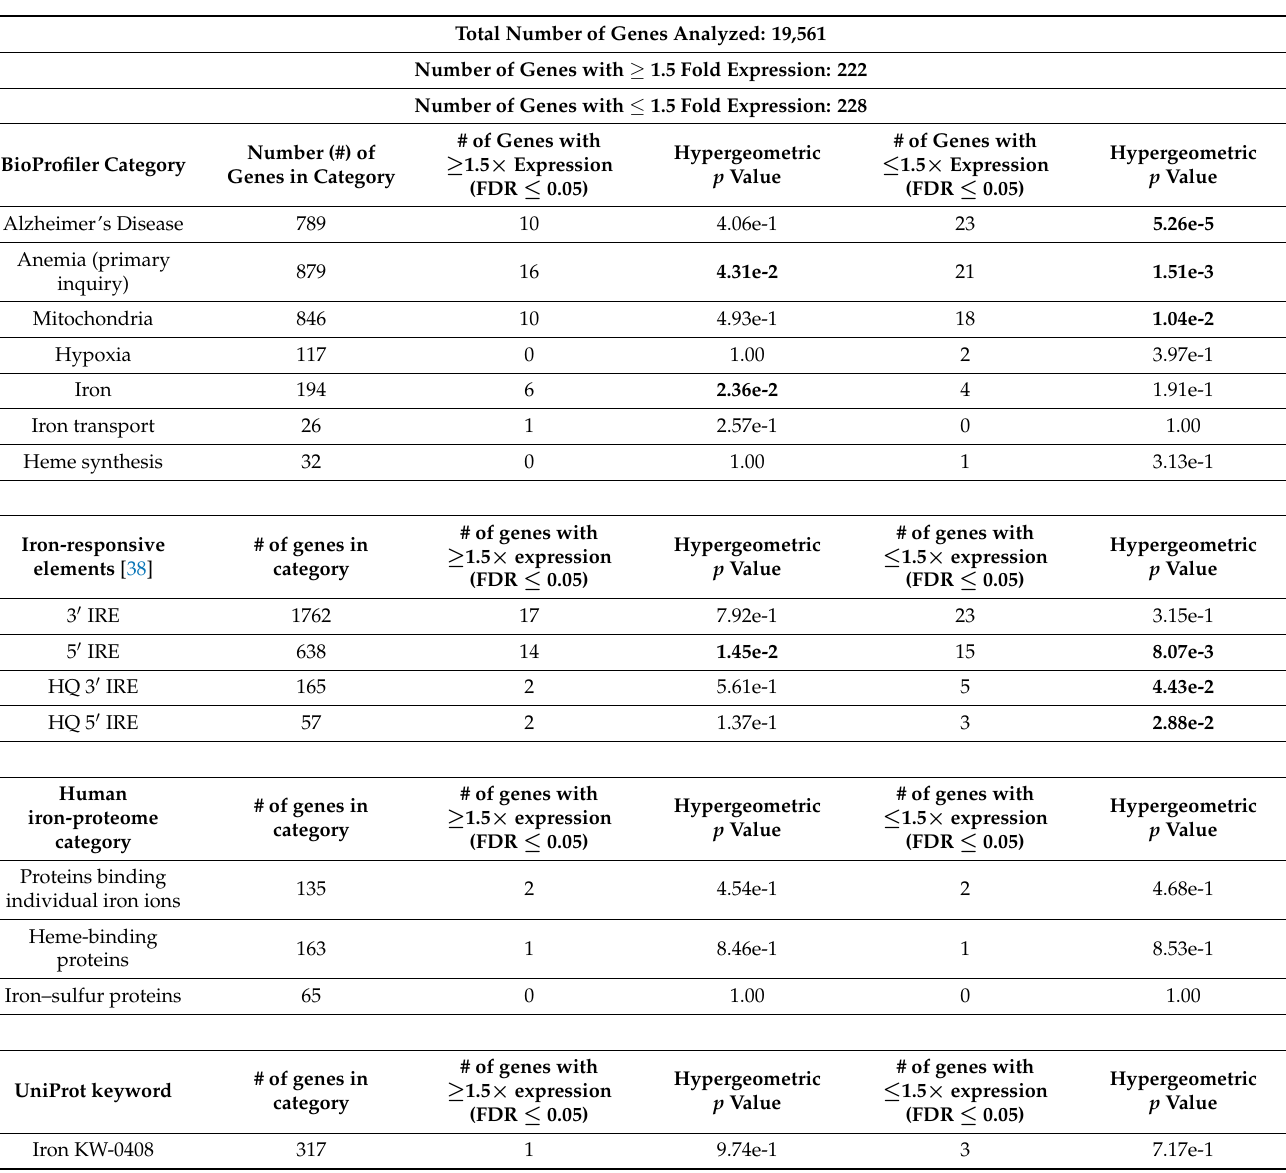
Table 2. PITRM1 KO vs. WT Cerebral Organoids from Induced Pluripotent Stem Cells—All Clus- ters Combined